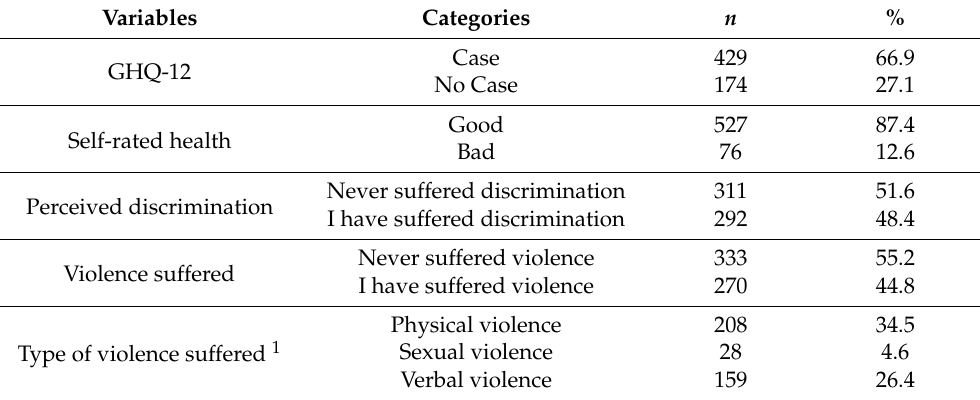
Table 2. Descriptive analyses for study